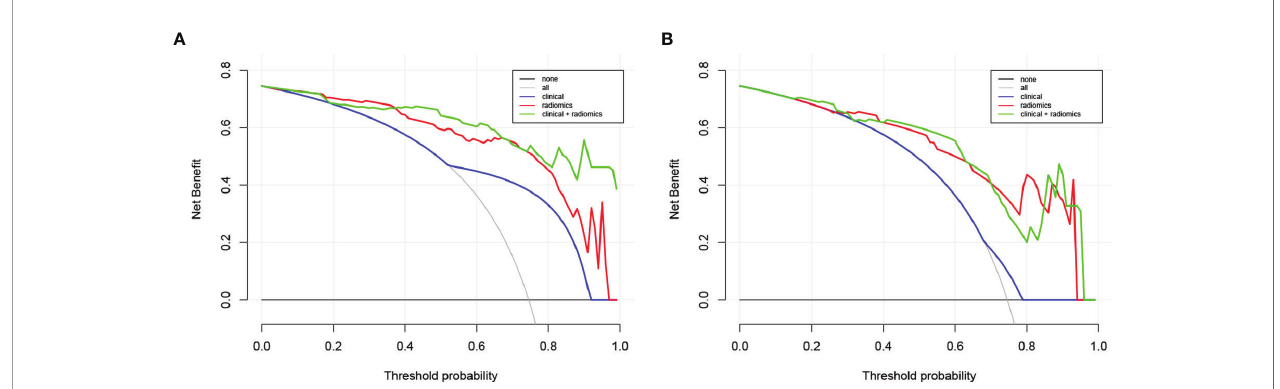
FIGURE 6 | Decision curve analysis for the combined model, radiomics model, and clinical model in the training dataset (A) and in the testing dataset (B) . The y-axis represents the net bene fi t. The gray line represents the assumption that all patients were con fi rmed with PNI; however, the black line is the opposite. The blue line represents the clinical model. The red line represents the radiomics model. The green line represents the